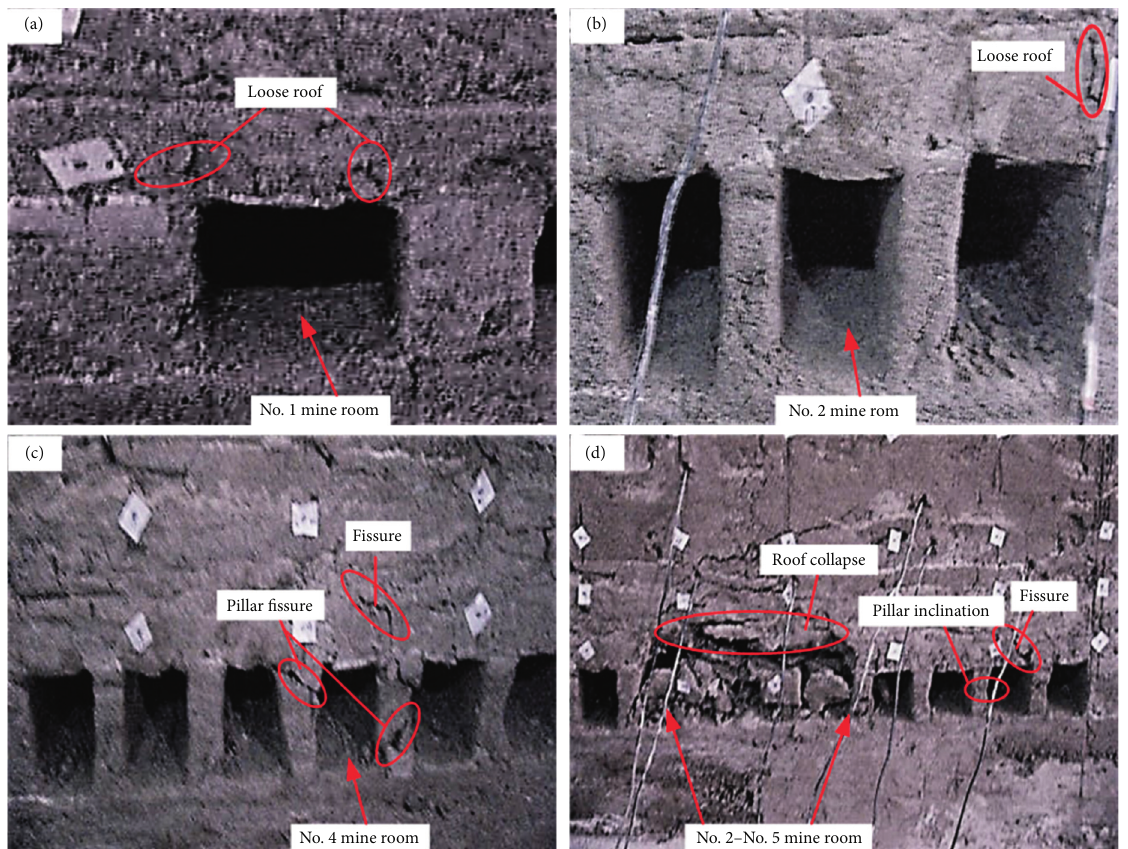
Figure 9: Deformation and failure characteristics of the roof for the 5 m ore pillars: (a) first step; (b) second step; (c) third step; (d) fourth